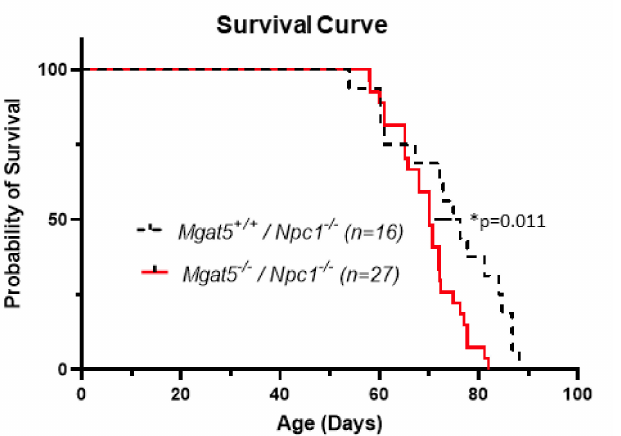
Figure 2. Kaplan–Meier survival curve. Mice were tracked for up to 12 weeks of age and end-of- life recorded. The median age of death of Mgat5 +/+ :Npc1 − / − mice (n = 16) was 75.6 days (range 54–88 days) and the median age of death of Mgat5 − / − :Npc1 − / − mice (n = 27) was 70 days (range 58–82 days), (log-rank test, * p =